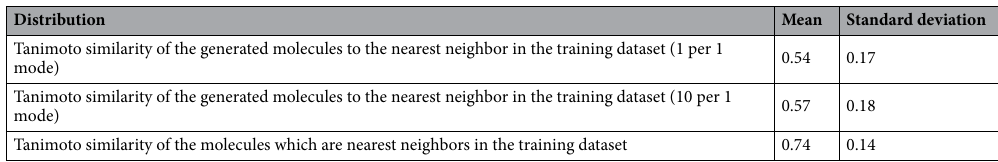
Table 6. Mean and standard deviation values of Tanimoto similarity